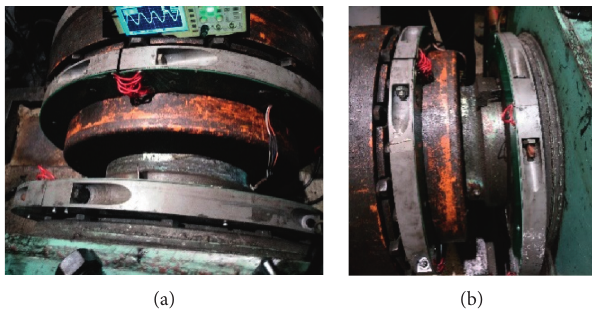
Figure 10: Field test setup photos.